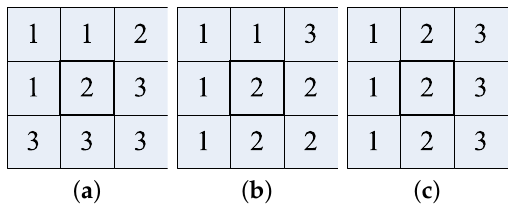
Figure 1. Three typical local spatial information of classification